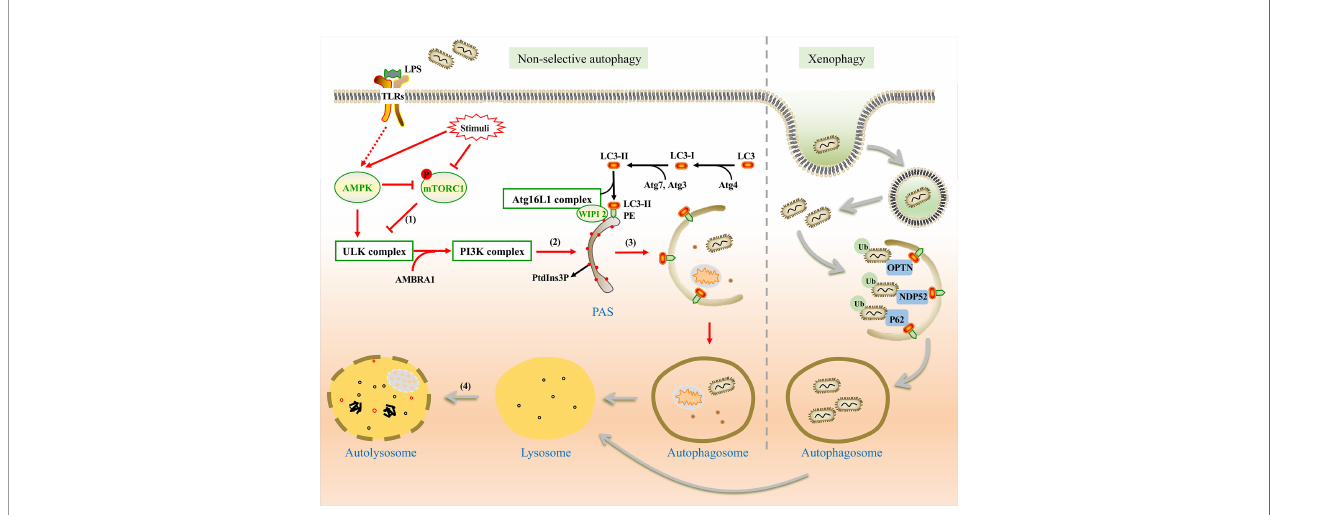
FIGURE 1 | The mechanism of non-selective and xenophagy. Non-selective autophagy (Left) is initiated by the stimulation of LPS. (1) Under the stimulation, AMPK is activated and mTORC1 is inhibited. Thus, the ULK1 complex is activated and phosphorylates the PI3K complex. (2) WIPI2 recruits the Atg16L1 complex to the pre-autophagosomal structure (PAS) by the PtdIns3P binding protein and promotes the conjugation between LC3-II and phosphatidylethanolamine (PE). (3) Autophagic membrane is expanded and completed. Damaged organelles, pathogens, and other components are encapsulated in autophagosomes without selection. (4) Autophagosome fuses with lysosome for degradation of the substances in vesicles. Xenophagy (Right) can capture bacteria selectively. With the help of ubiquitin-binding protein adaptors, such as p62, OPTN, and NDP52, ubiquitinated bacteria are captured by autophagosome for